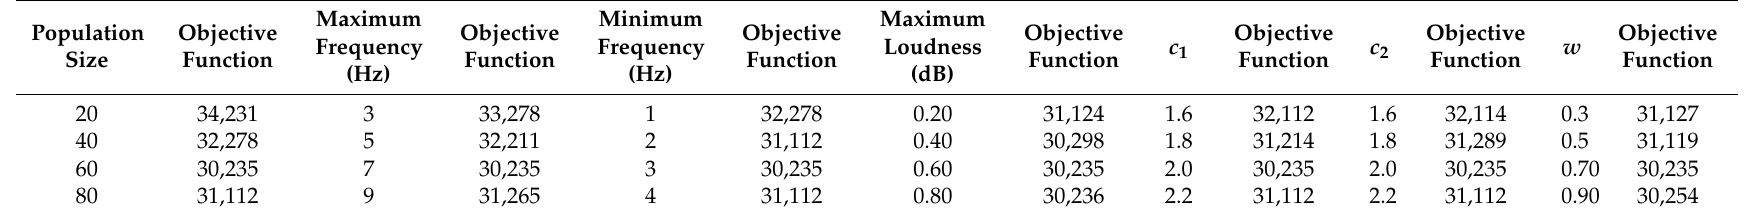
Table 14. Sensitivity analysis for Karahan flood.